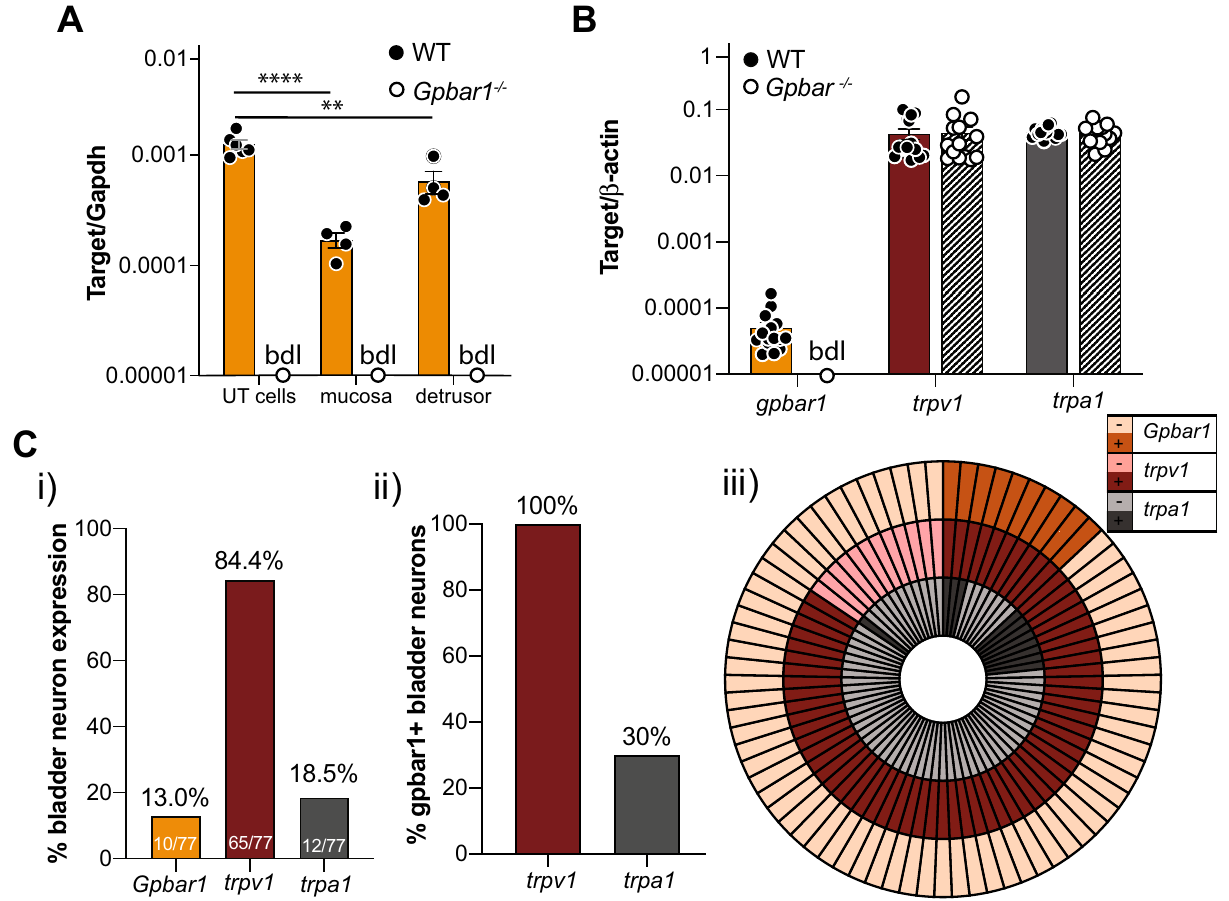
Figure 5. Relative mRNA expression in bladder tissue, lumbosacral DRG and isolated bladder-innervating DRG neurons. ( A ) qRT-PCR was used to determine the relative abundance of the TGR5 gene Gpbar1 in urothelial cells, mucosal urothelium, and detrusor smooth muscle of the bladder of wild-type and Gpbar1 −/− mice. Gpbar1 was expressed in all layers of the wildtype bladder, with relative abundance in the isolated urothelial cells (UT cells; N = 6 mice) significantly higher than in the mucosa (N = 4 mice; **** P < 0.0001) and detrusor (N = 4 mice; ** P < 0.01). No significant difference was observed between mucosa and detrusor layers (ns, P = 0.0833). Gpbar1 mRNA expression was below detectable levels (bdl) in all tissues tested from Gpbar1 −/− mice. ( B ) Relative mRNA expression of Gpbar1 , trpv1 and trpa1 in lumbosacral (LS) dorsal root ganglia (DRG) from wildtype and Gpbar1 −/− mice. Gpbar1 is expressed in LS DRG from WT mice. Gpbar1 levels were below the detectable limit (bdl) in Gpbar1 −/− mice. No differences were observed between wildtype and Gpbar1 −/− mice for the highly expressed genes trpv1 or trpa1 . ( C ) ( i ) Gpbar1 , trpv1 and trpa1 mRNA expression in isolated, retrogradely traced bladder-innervating DRG neurons was determined with single cell RT-PCR. 13% of bladder neurons (10 out of 77 neurons, N = 3) expressed Gpbar1 , while 84.4% (65 out of 77 neurons) expressed trpv1 and 18.5% (12 out of 77 neurons) expressed trpa1 . ( ii ) Of the 10 bladder-innervating DRG neurons expressing Gpbar1 , 100% (10 out of 10) co-expressed trpv1 , while 30% (3 out of 10) co-expressed trpa1 . ( iii ) Polar plot depicting the expression profile (dark shading: expressing target; light shading: not expressing target) of each bladder-innervating DRG neuron with respect to Gpbar1 (outer ring), Trpv1 (middle ring) and Trpa1 (inner ring). Data are represented as mean ± SEM (2 −ΔCt ) on a log10 scale ( A , B ), or percentage of neurons ( Ci , Cii ). P values above are based on one-way ANOVA with Tukey’s multiple comparison test, with Gpbar1 −/− not included in the